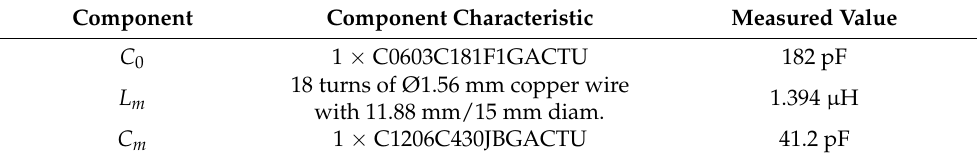
Table 4. Values of the passive components used to replace the piezoelectric resonator.